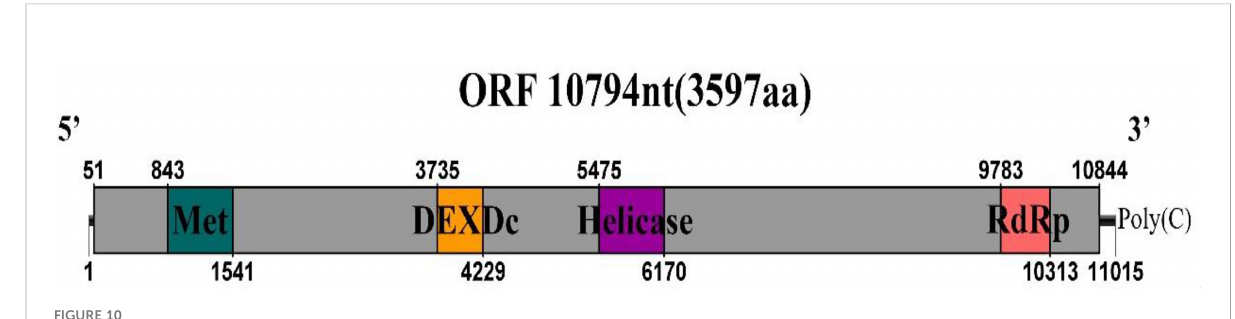
FIGURE 10 Diagrammatic representations of the predicted genomic organization of PvEV2. Comparisons of the genomic organizations of the novel P. vexans infecting PvEV2 and the identi fi ed member PvEV2 of the Endornaviridae family. PvEV2 was completely sequenced and predicted to harbor a single larger ORF containing domains of viral methyltransferase (MTR), putative DEXDc, viral helicase (Hel) and RdRp, which are indicated in the ORF box.